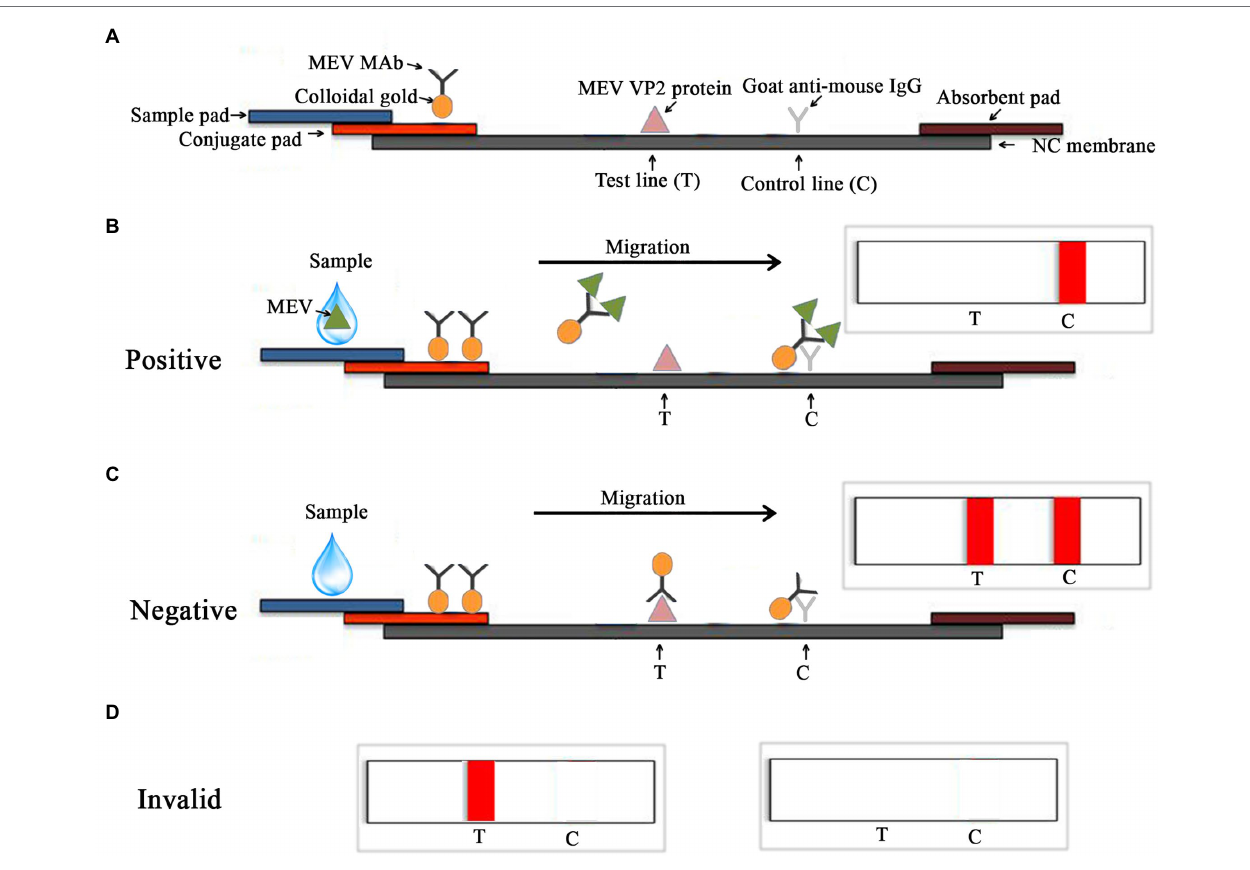
FIGURE 1 | Schematic diagram of the MEV competitive ICS assay. (A) Schematic side view of colloidal gold competition and the principle of detection. The sample contained the MEV, the colloidal gold-monoclonal antibody (MAb) 14 conjugates would combine with the MEV. When the antigen–antibody complex migrated to the C line, it would combine with goat anti-mouse IgG, and a band would appear at the C line (B) . If two bands were observed at both the T and C lines, the sample was considered negative (C) . The test is invalid if only one band appears at T line and no band is present (D)